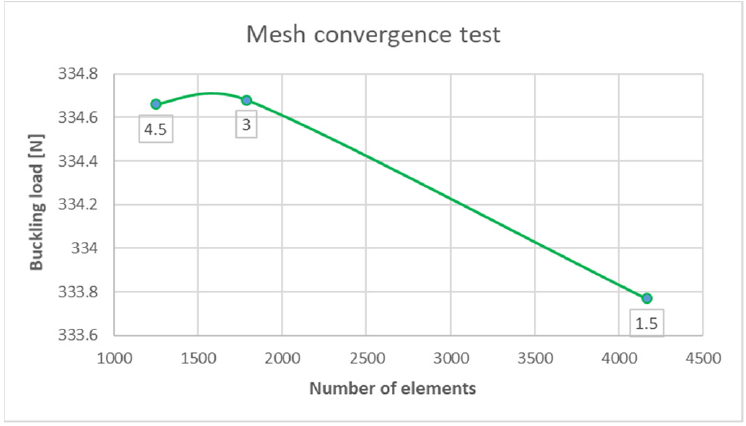
Figure 4. Numerical model with boundary conditions.